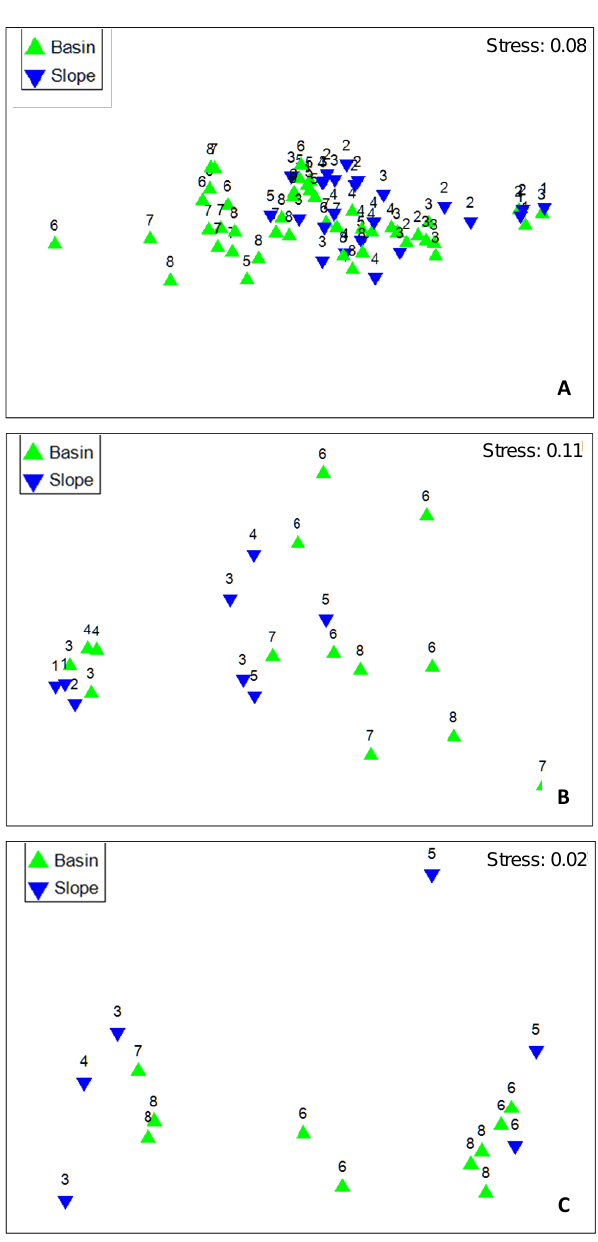
Fig. 5. nMDS ordination based on (A) major meiofaunal taxa, (B) nematode genera composition and (C) microbial OTUs. Numbers indicate the different depth ranges. 1: < 500m; 2: 500–1000m; 3: 1000–1500m; 4: 1500–2000m; 5: 2000–2500m; 6: 2500–3000m; 7: 3000–3500m; 8: > 3500m.